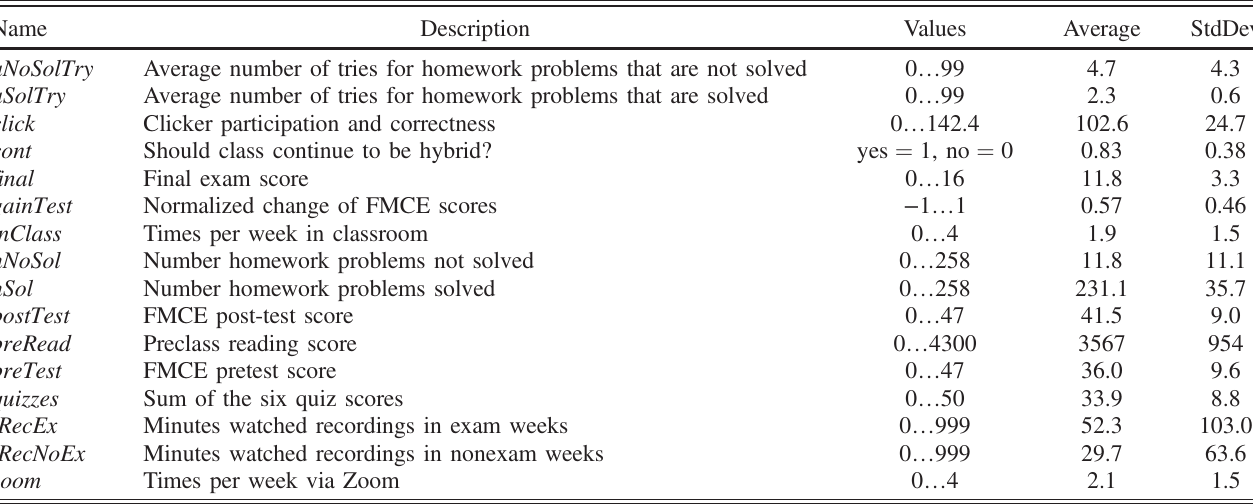
TABLE I. Learner attributes used for this study, including their range, averages, and standard